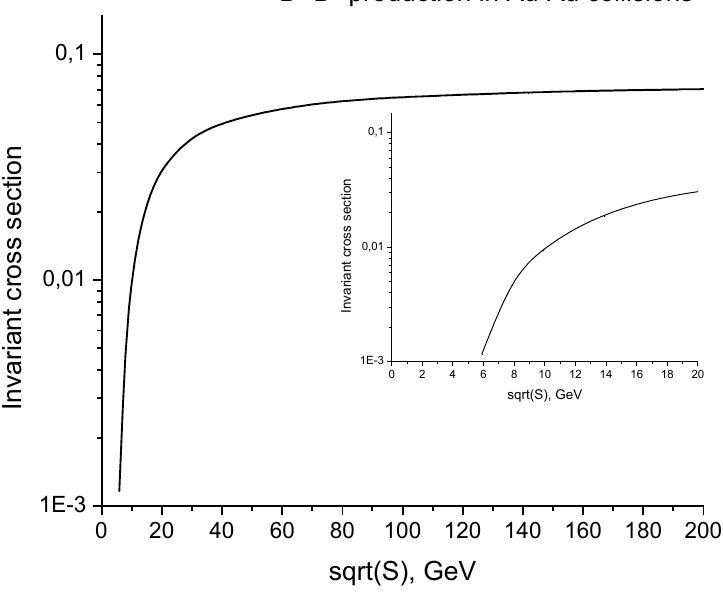
Figure 1a. Invariant cross section (mb·GeV -2 ·c 3 ·sr -1 ) of the D+D- meson production at 0º and 10 MeV in Au-Au collisions as a function of S 1/2